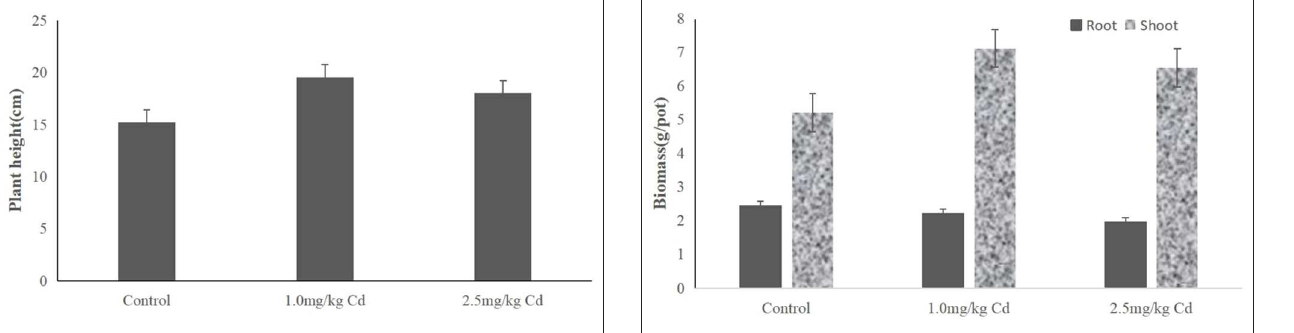
concentrated HNO 3 and 13% concentrated HClO 4 (V/V) (Wei et al., 2005). The concentration of Cd, Ca, Cu, Fe, Mg, Mn, Mo, P, and Zn was analyzed using ICP-AES (Spectro arcos, Germany).